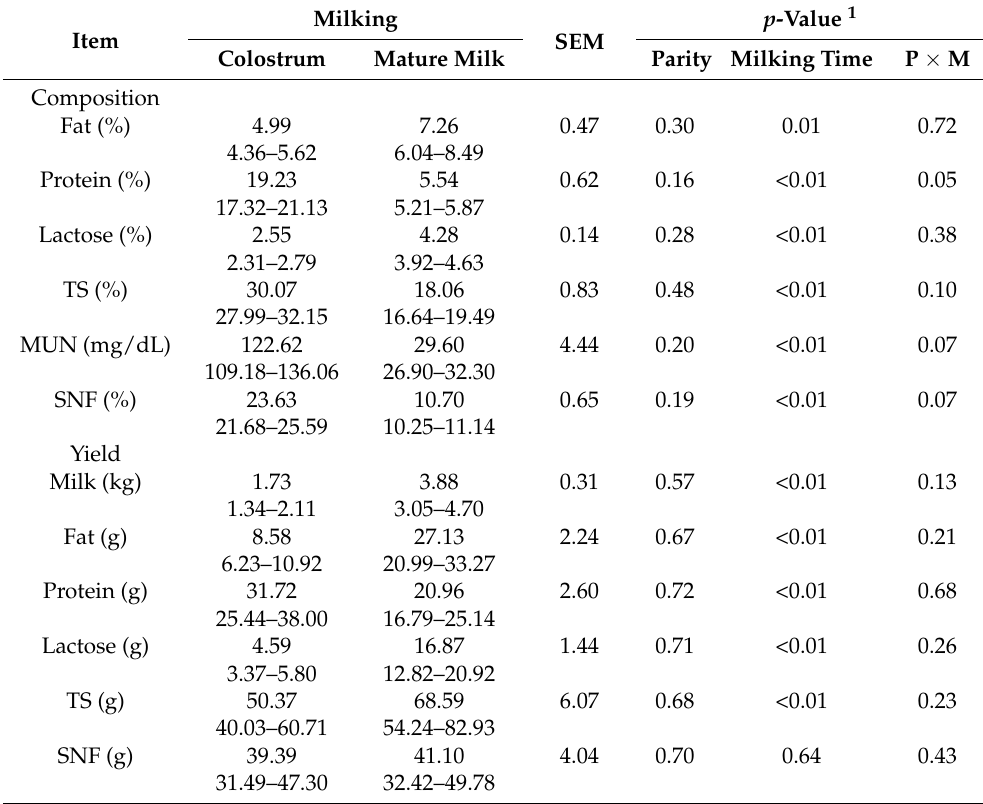
Table 3. Least squares means and 95% CI for composition and yields in colostrum and mature milk with different parities and milking time (n =